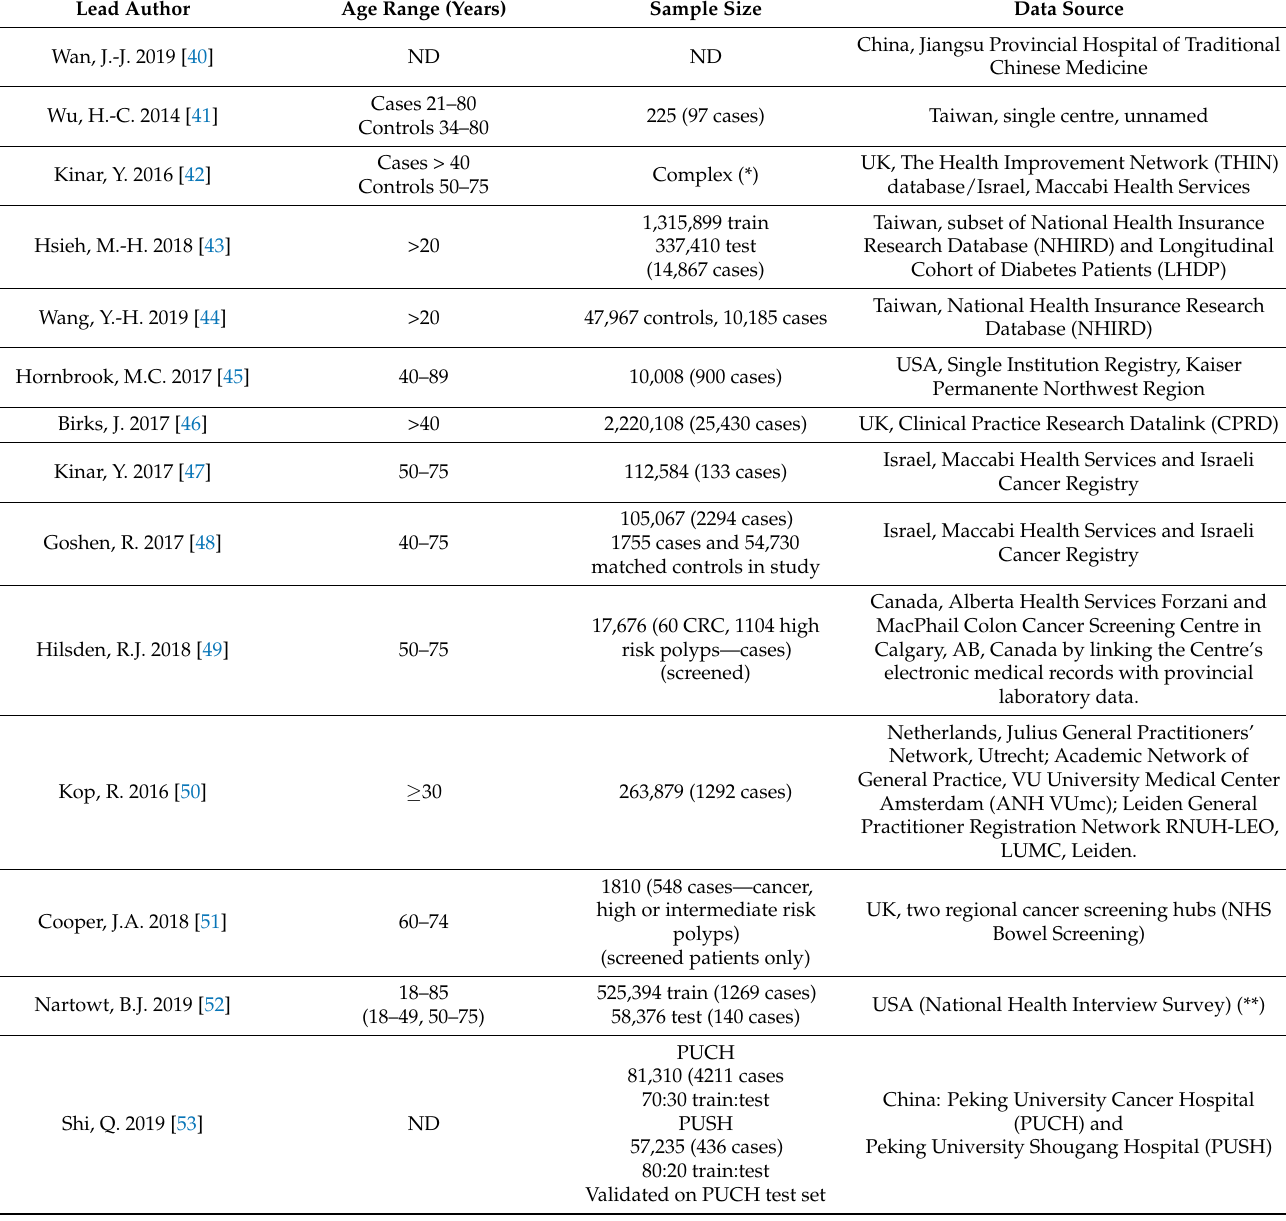
Table 2. Summary of model purpose, study population and data